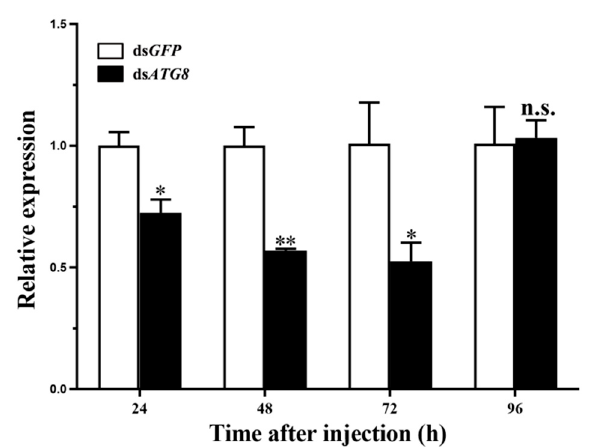
Figure 4. Changes in the messenger RNA level after treatment with specific RNA interference. Relative transcript levels of HvATG8 in L5D1 larvae after injection with dsHvATG8 at a concentration of 3.0 µ g / µ L for 24, 48, 72, and 96 h. The sample size was 150 larvae that were divided into three biological replicates. Error bars represent mean ± standard error of three biological replicates. * p < 0.05, ** p < 0.01, n.s. not significant. According to two-way analysis of variance (ANOVA) followed by u-test.